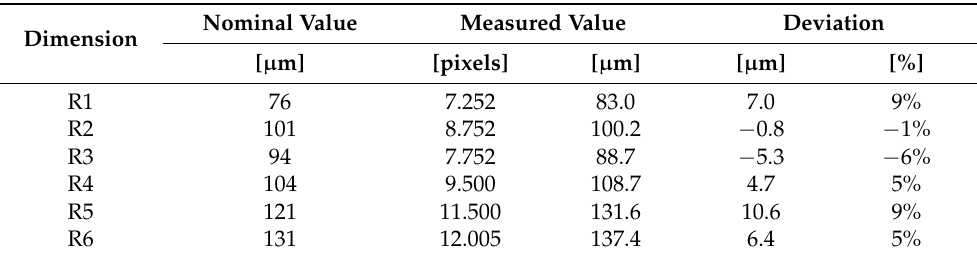
Table 3. Estimate of the radii close to the SsDRA origin: nominal values, measured values, and deviations from nominal